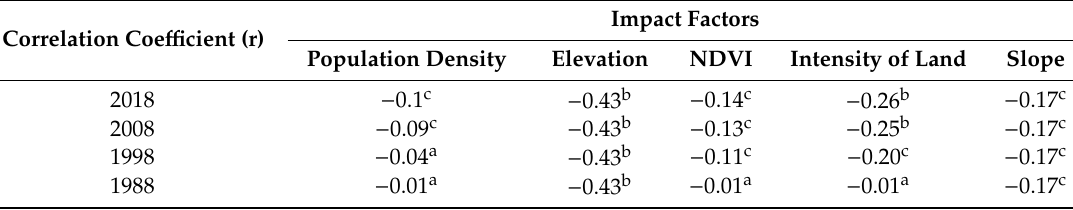
Table 13. The correlation of impact factors and habitat quality.